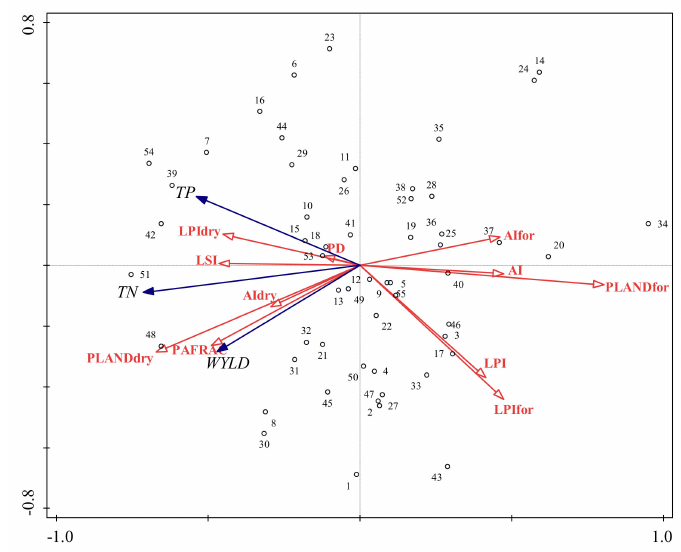
Figure 9. Redundancy analysis (RDA) triplots displaying the relationship among water yield (WYLD), total nitrogen (TN) and total phosphorus (TP) loading, and landscape metrics. Percentage of landscape (PLAND) of forestland (PLANDfor), PLAND of dry farmland (PLANDdry), Perimeter area fractal dimension (PAFRAC), Patch density (PD), Landscape shape index (LSI), Largest patch index (LPI), LPI of forestland (LPIfor), LPI of dry farmland (LPIdry), Aggregation index (AI), AI of forestland (AIfor), AI of dry farmland